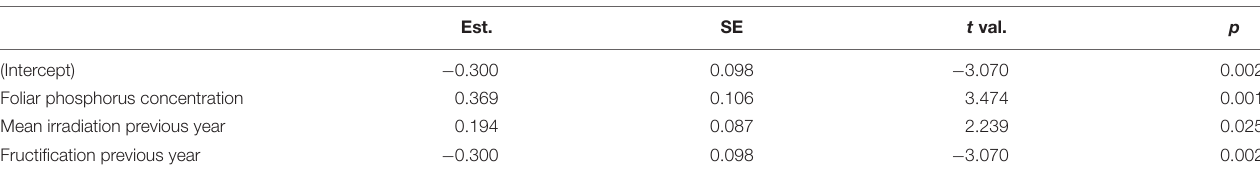
TABLE 3 | Results of a mixed binomial regression model of photobleaching at the harvested shoots. Est. SE z val. p − 11 .